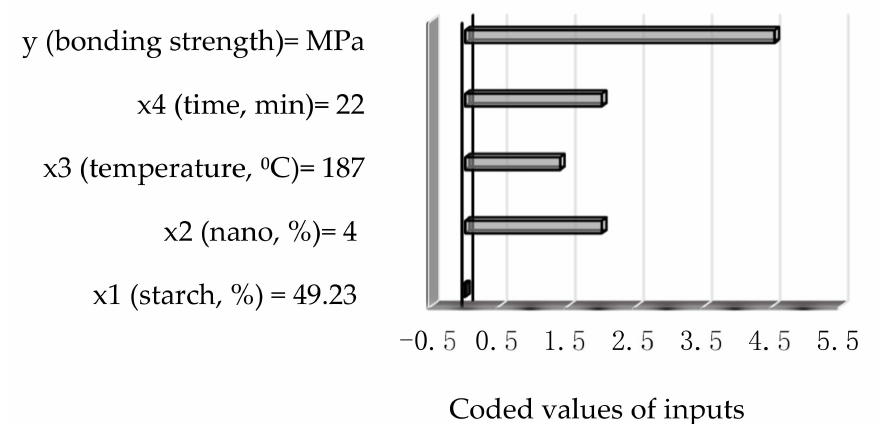
Figure 9. The optimal values of the application of the input variables to achieve the best response based on the developed ANN